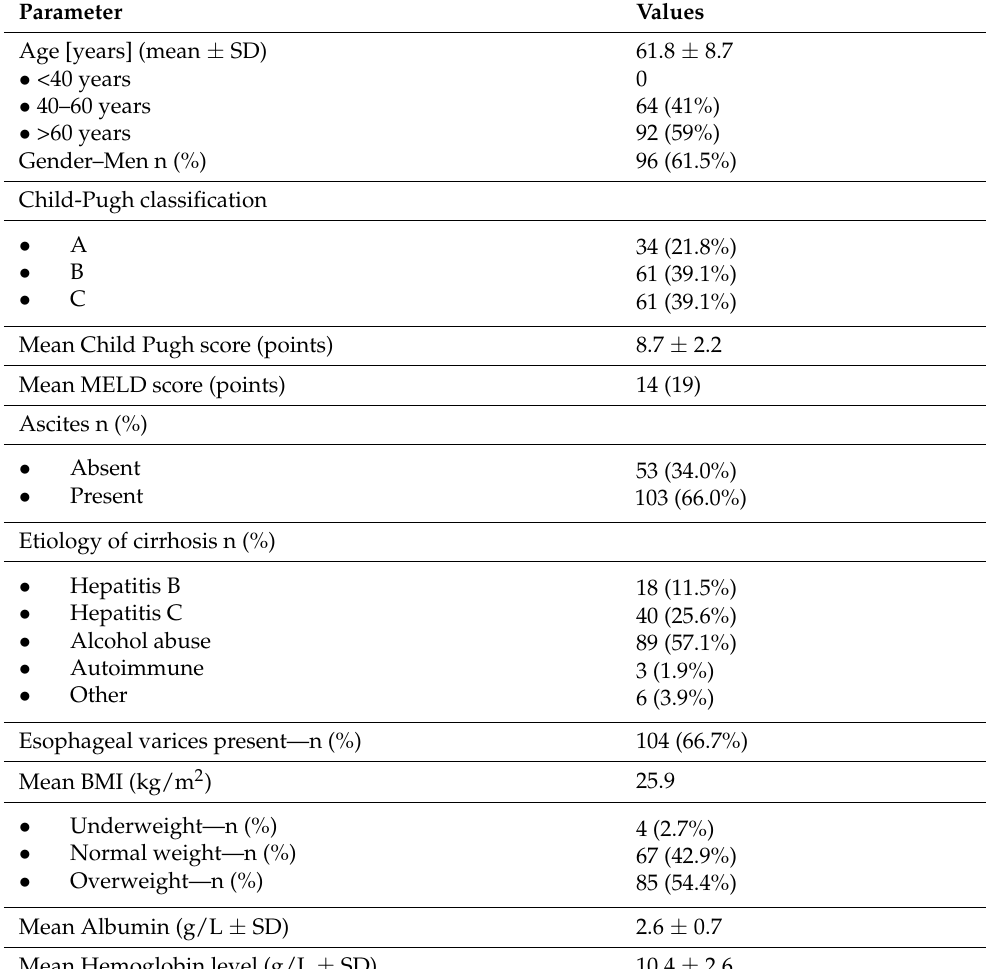
Table 1. Baseline characteristics of the 156 patients